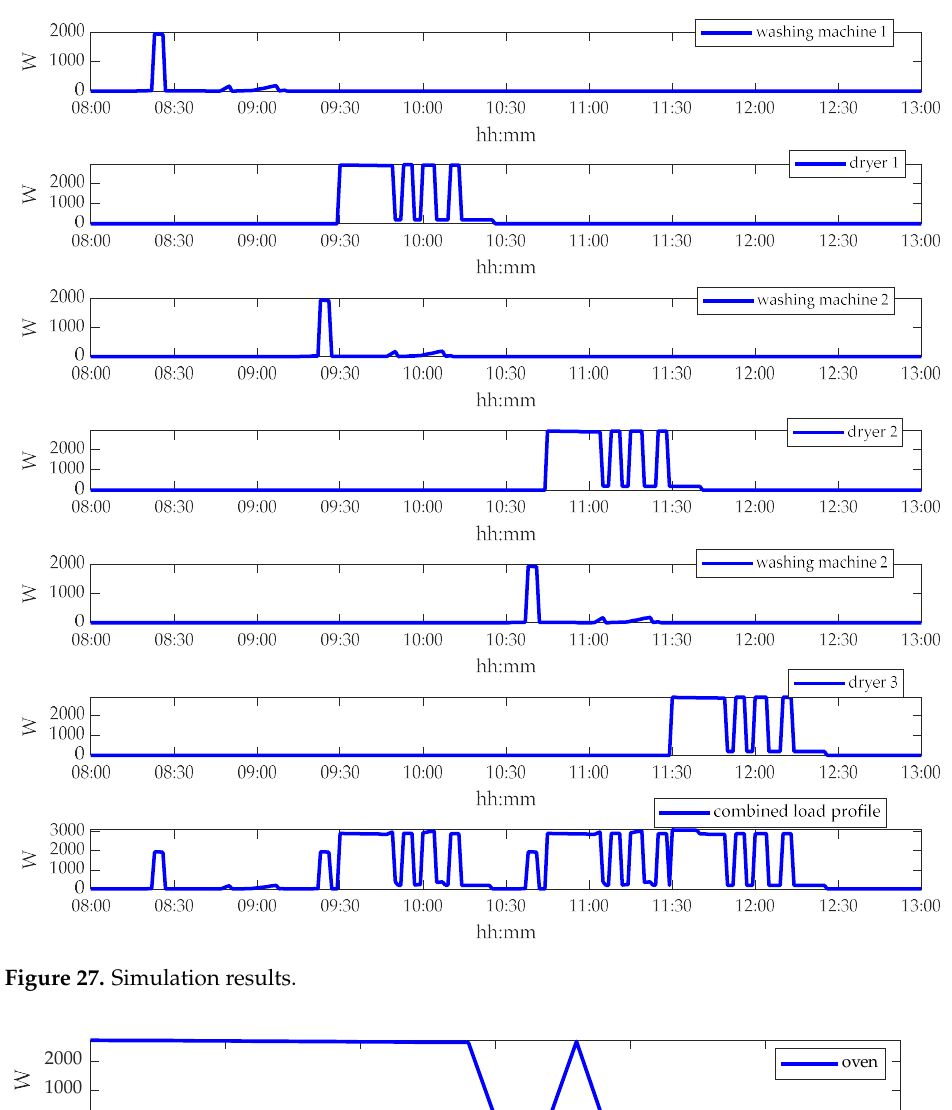
Figure 28. Profile of the non-shiftable load used in simulation (sampling time 1 min).